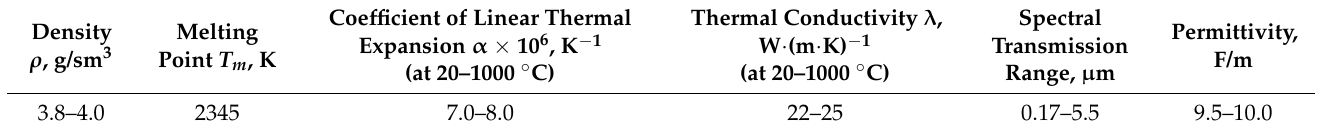
Table 1. Some physical, thermal, optical and electrical properties of